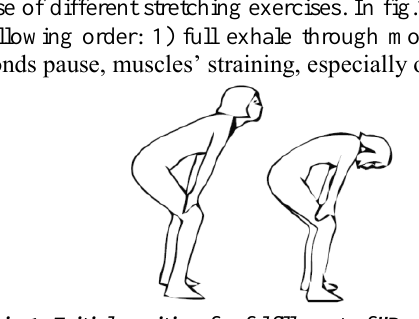
Fig.1. Initial position for fulfillment of "Body Flex». Source